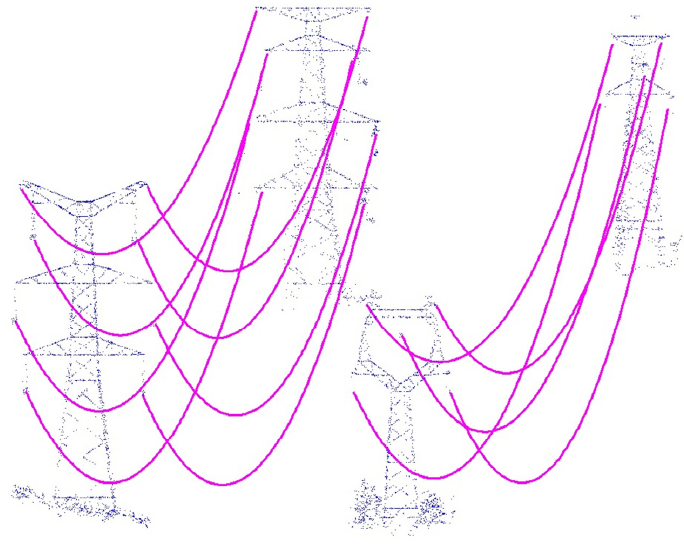
Figure 7. Power-line reconstruction results.